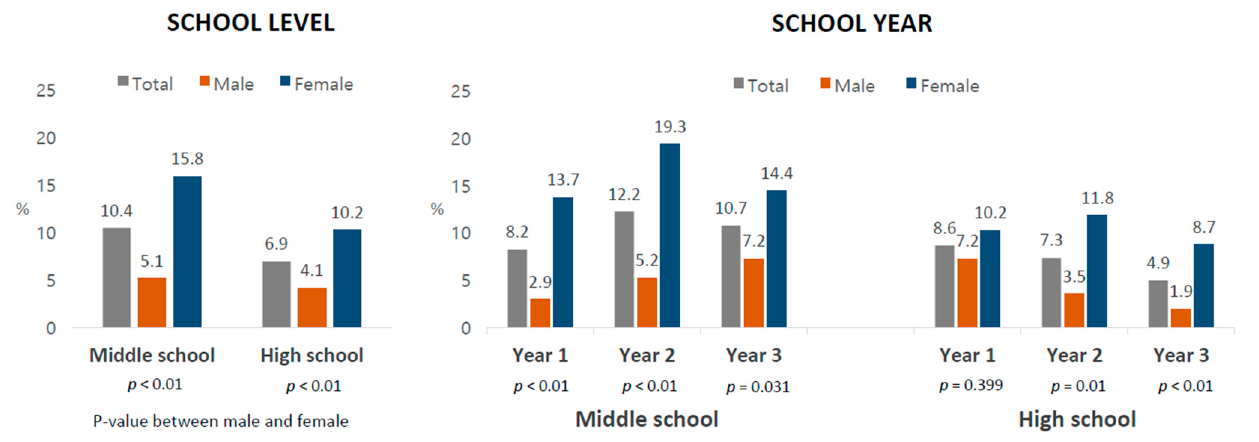
Figure 3. 12-month prevalence of non-suicidal self-injury by gender among adolescent students in South Korea, 2019.